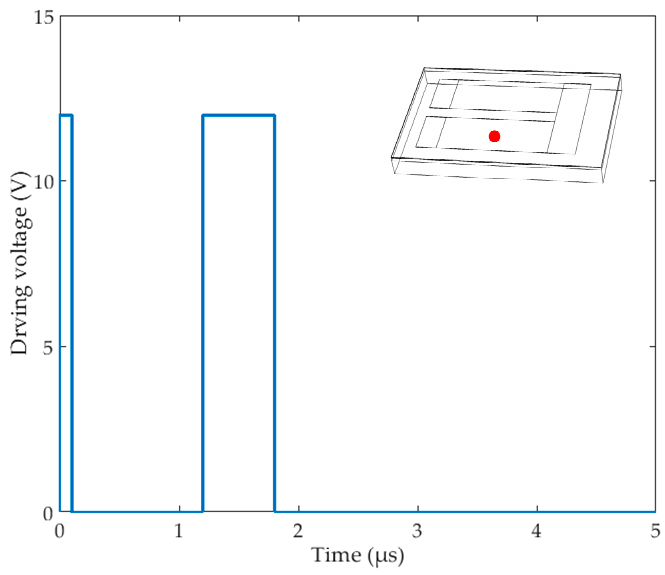
Figure 4. The driving signal of the heating resistors and the key point on the surface.